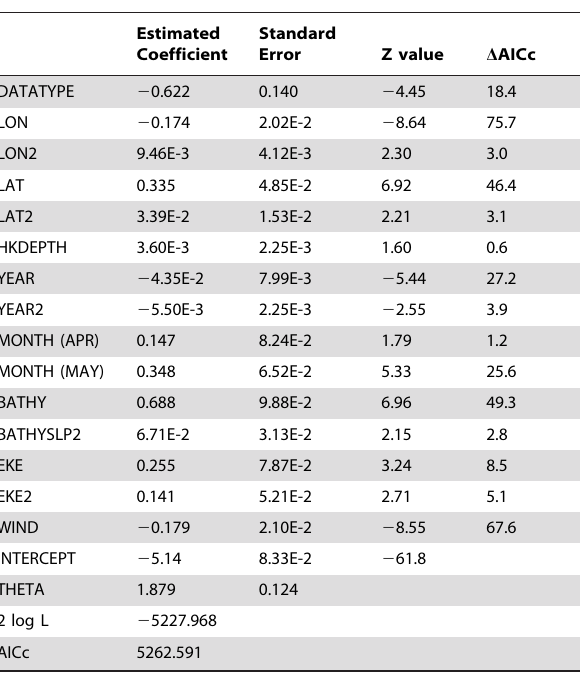
Table 3. Parameters and estimated coefficients of final yellowfin tuna